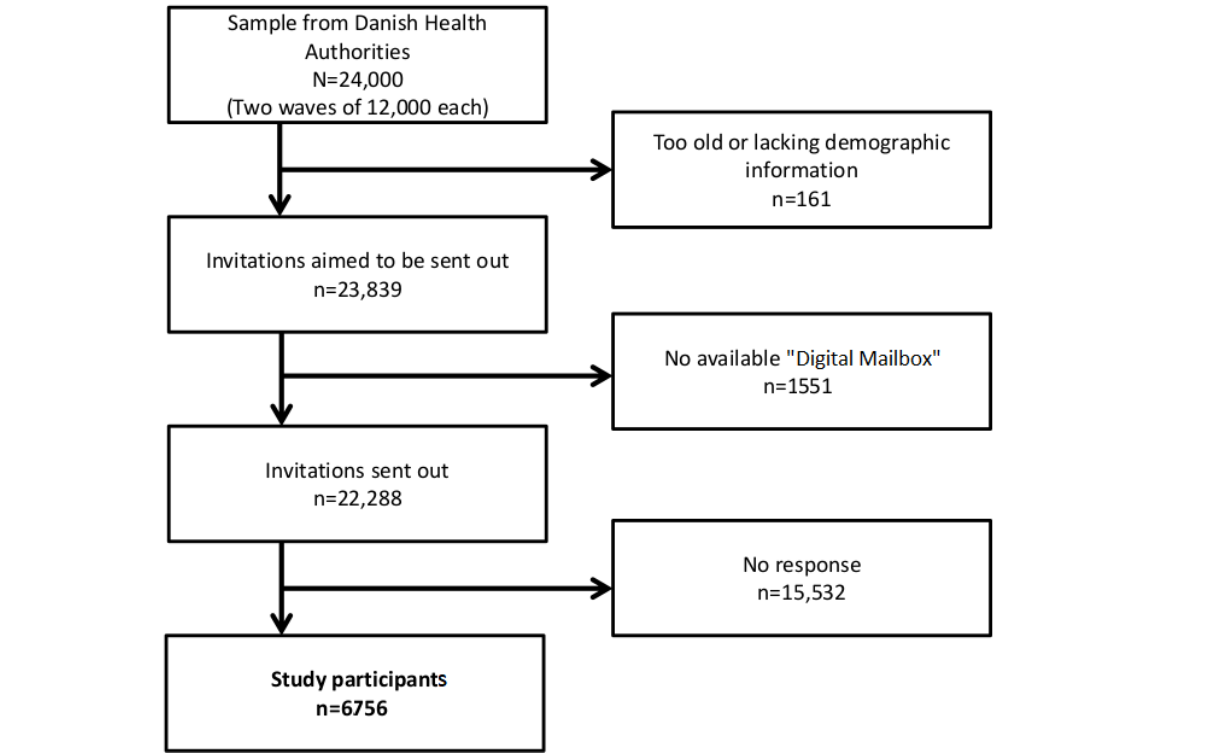
Figure 1. Flowchart showing the inclusion of study